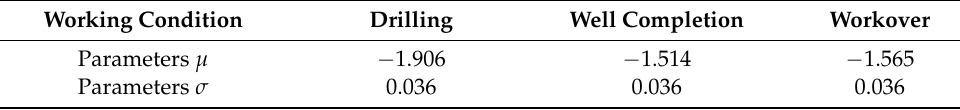
Table 6. Parameters of PDF for well completion and